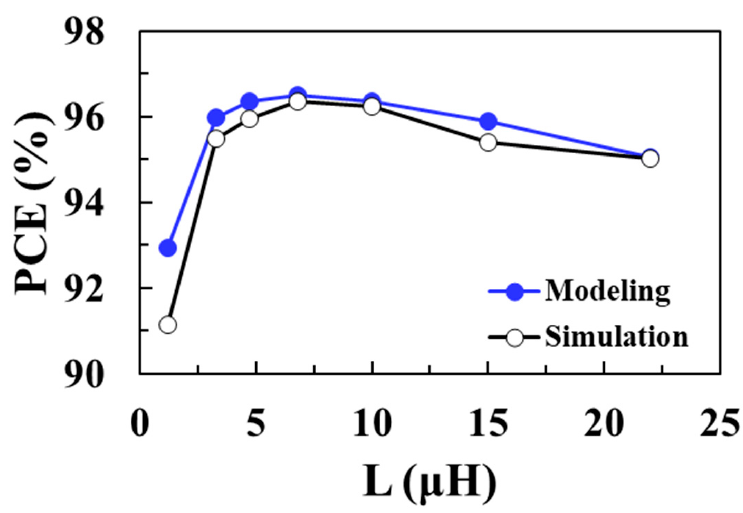
Figure 14. PCE according to inductance for an input voltage of 0.1 V and comparison with the modeling results.